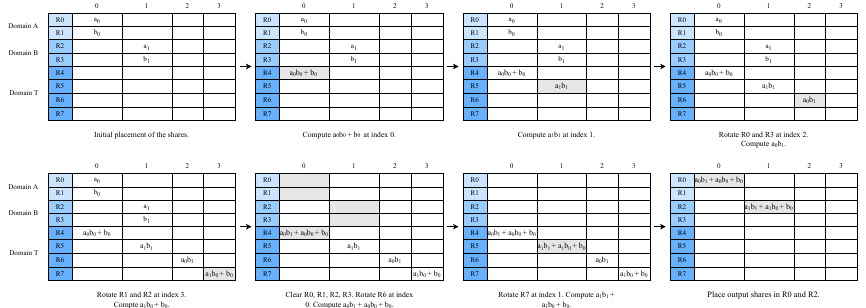
Figure 4: Methodology for d + 1 shares. In this masking, registers R0-R1, R2-R3 belong to domain A and B respectively and R4-R7 are temporary registers in domain